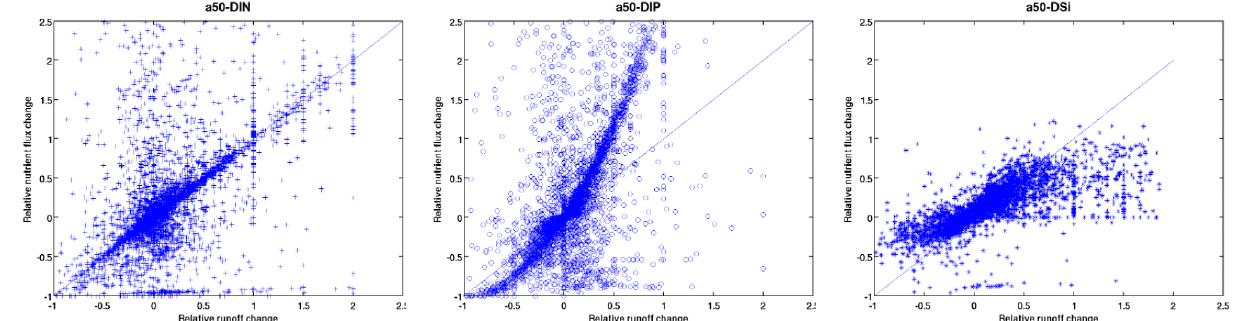
Figure A3. The relationship between relative changes in freshwater runoff and relative changes in nutrient fluxes (dissolved inorganic nitrogen, phosphorus, and silicon) in 2050 according to the Adapting Mosaic future scenario in NEWS 2